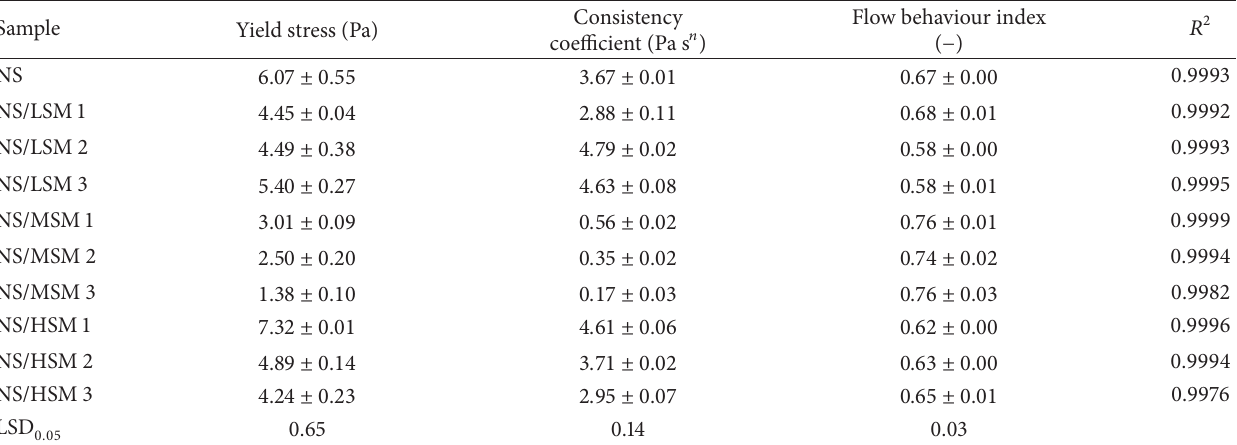
Table 2: Herschley-Bulkel model parameters of native starch paste and blends with maltodextrins.